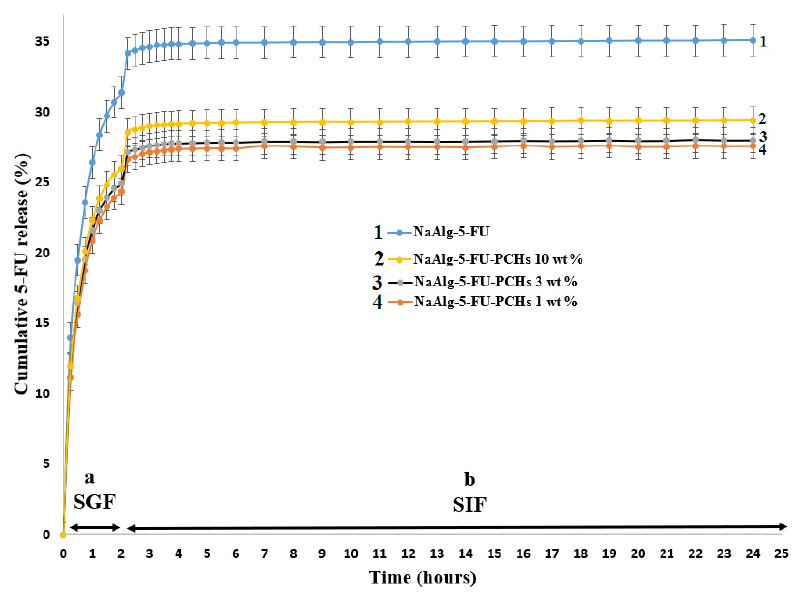
Figure 8. Drug release profiles in SGF (a) and SIF (b) for: 1-NaAlg-5-FU, 2-NaAlg-5-FU-PCHs 10 wt%, 3-NaAlg-5-FU-PCHs 3 wt%, 4-NaAlg-5-FU-PCHs 1 wt%.